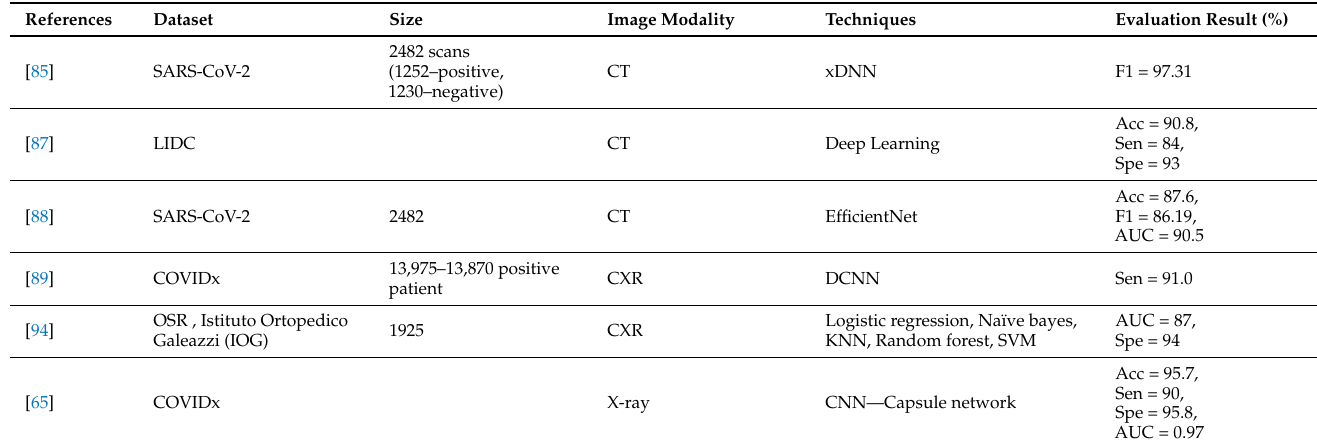
Table 2. COVID-19 datasets available for developing ML